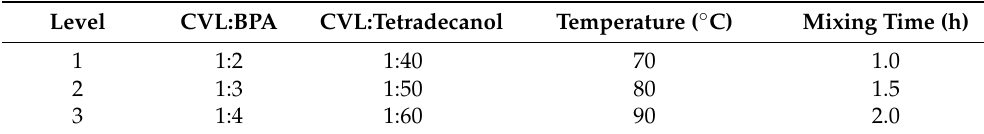
Table 2. Influencing factors and levels.